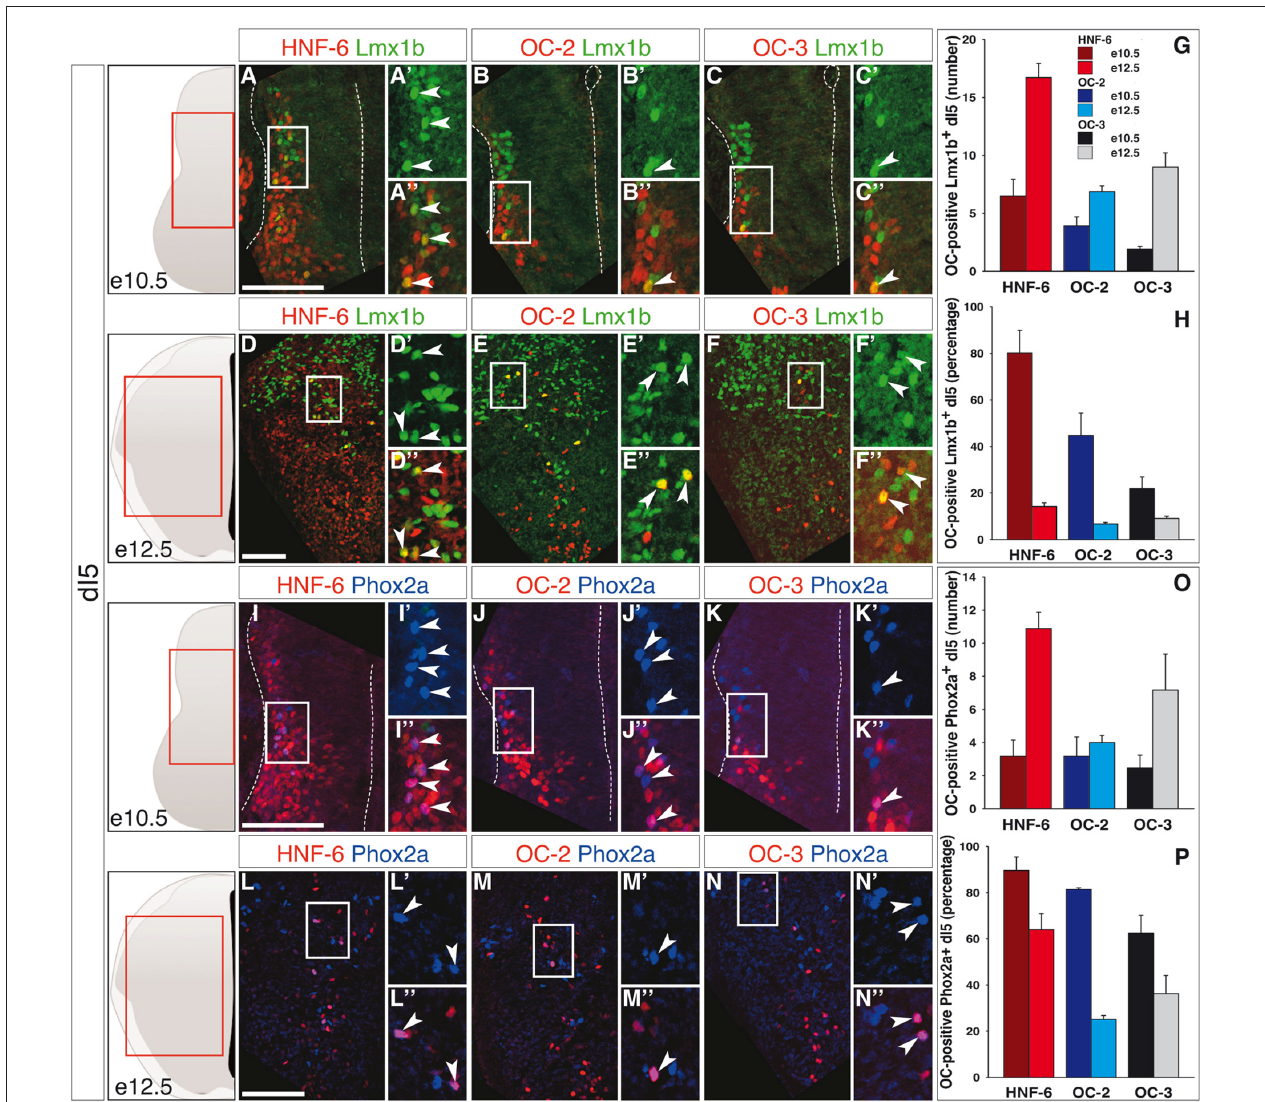
FIGURE 2 | OC factors are differentially and dynamically distributed in dI5 population and sub-population during development. (A–F) Immunodetection of HNF-6, OC-2 or OC-3 (red) in Lmx1b + (green) dI5 population on transverse sections of thoracic spinal cord at e10.5 (A–C) and e12.5 (D–F) . At e10.5, HNF-6 (A–A”) , OC-2 (B–B”) and OC-3 (C–C”) are detected in a large number of dI5 neurons. At e12.5, the presence of HNF-6 (D–D”) , OC-2 (E–E”) and OC-3 (F–F”) is still observed in a few Lmx1b + dI5 neurons. (G–H) Quantifications of dI5 neurons containing HNF-6, OC-2 or OC-3 at embryonic stages e10.5 and e12.5 show that HNF-6 is broadly present in early Lmx1b + dI5 neurons at e10.5 while OC-2 and OC-3 are less represented. Between e10.5 and e12.5, the number of dI5 neurons containing OC factors increases (G) but the ratio of those OC-positive neurons within Lmx1b + dI5 population decreases (H) . (I–N) Immunodetection of HNF-6, OC-2 or OC-3 (red) in Phox2a + (blue) dI5 subpopulation on transverse sections of thoracic spinal cord at e10.5 (I–K) and e12.5 (L–N) . At e10.5, HNF-6 (I–I”) , OC-2 (J–J”) and OC-3 (K–K”) are detected in most of Phox2a + dI5. At e12.5, HNF-6 (L–L”) , OC-2 (M–M”) and OC-3 (N–N”) are still visible in a significant number of Phox2a + interneurons. (O–P) Quantifications show an extended presence of OC factors in Phox2a subpopulation at e10.5 (P) . As observed in Lmx1b + dI5 population, the number of OC-positive cells increases between stages e10.5 and e12.5 (O) , along with a moderate decrease in the ratio of Phox2a + neurons containing OC factors (P) . The pictures show left hemisections as indicated to the left. Dashed lines delineate the spinal cord and the lumen of the ventricle. Insets are magnified views of boxed regions. Arrowheads point to double-labeled cells. Mean values ± SEM, n ≥ 3; color code as for Figure 1 . Scale bars = 100 µ m.